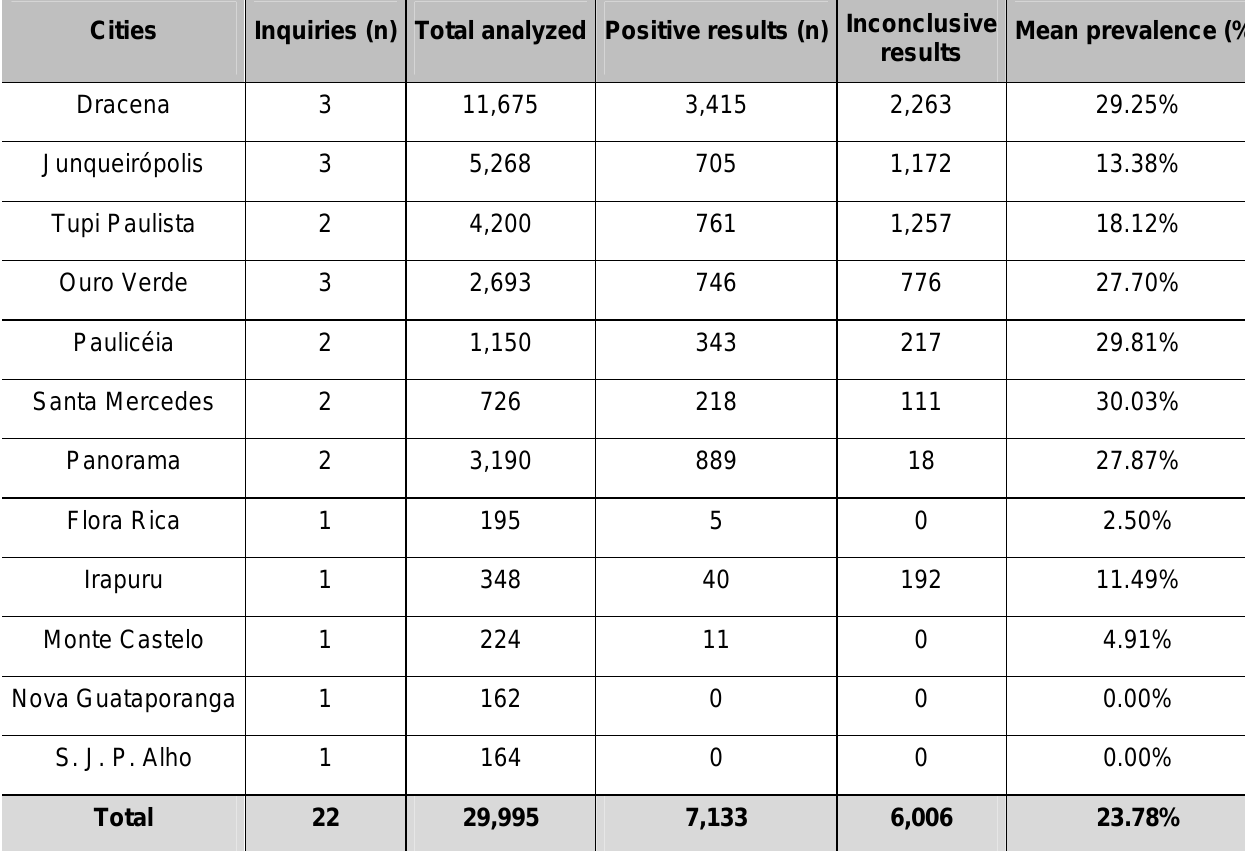
Table 4. Mean antibody prevalence of Leishmania sp. among dogs from Dracena microregion, Alta Paulista (SP), from August 2005 to January 2008 Cities Inquiries (n) Total analyzed Positive results (n) Inconclusive